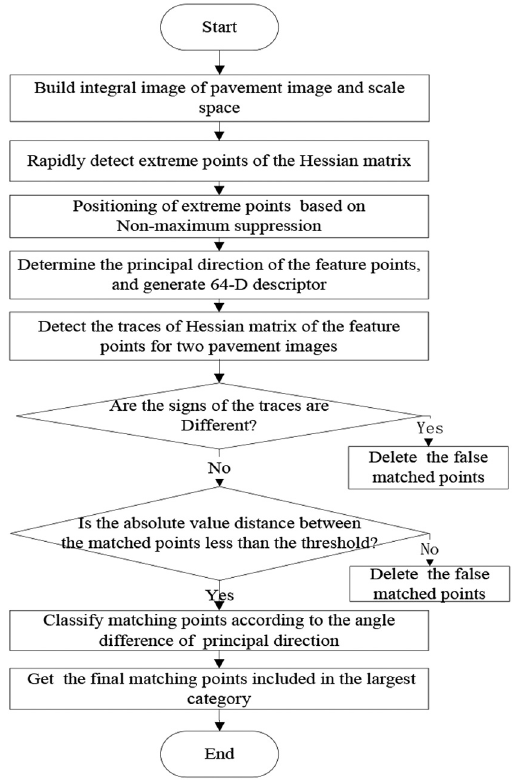
Figure 4 The fl ow chart of improved SURF